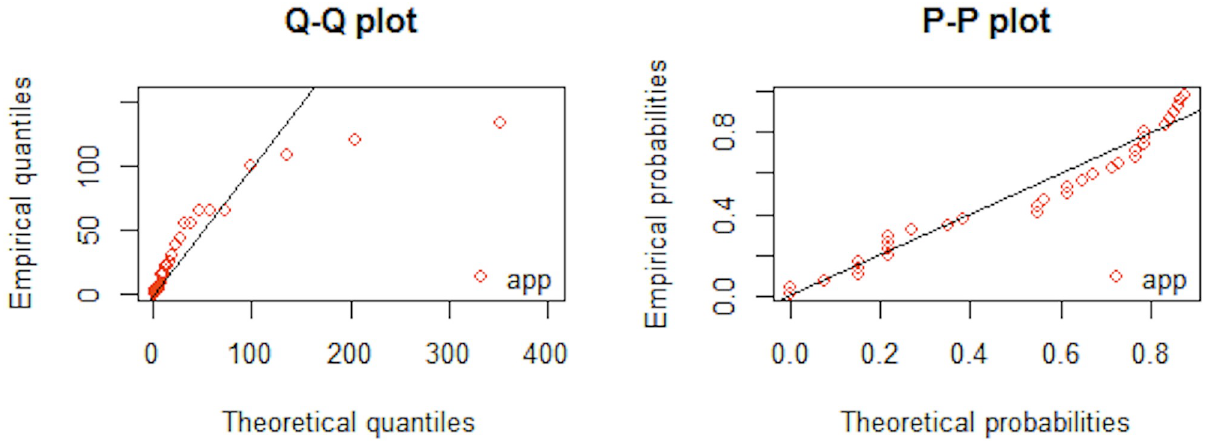
Fig 6. QQ-plot and PP-plot of APP distribution for dataset